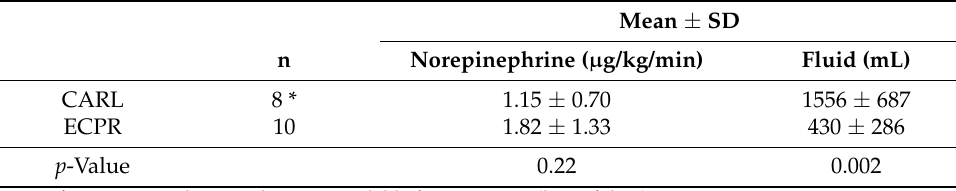
Table 1. Norepinephrine and fluid use in reperfusion phase.